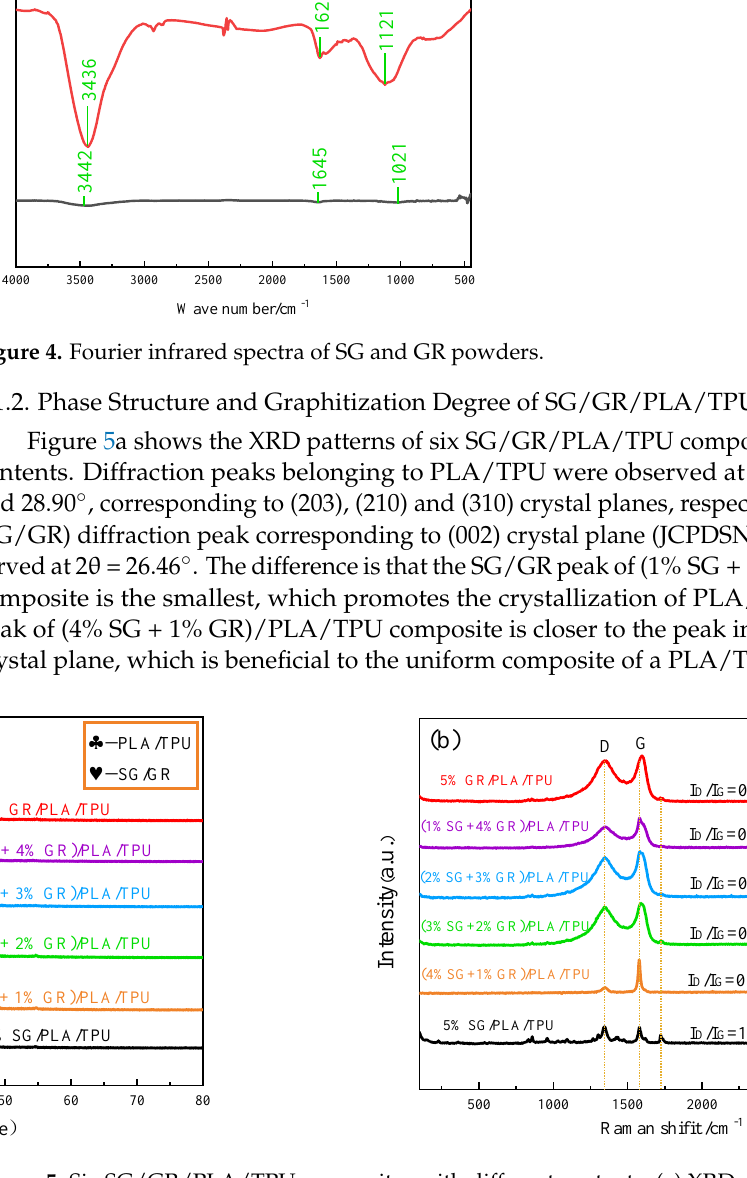
Figure 5. Six SG/GR/PLA/TPU composites with different contents: ( a ) XRD; ( b ) Raman spectrum.